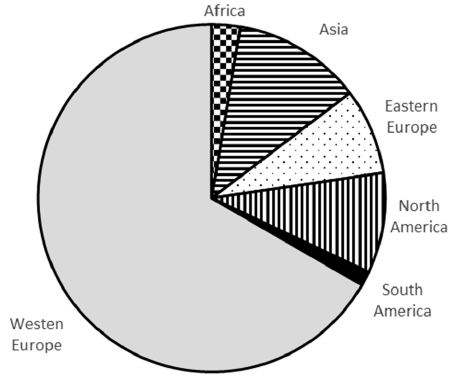
Figure 3. Regional distribution of empirical data.